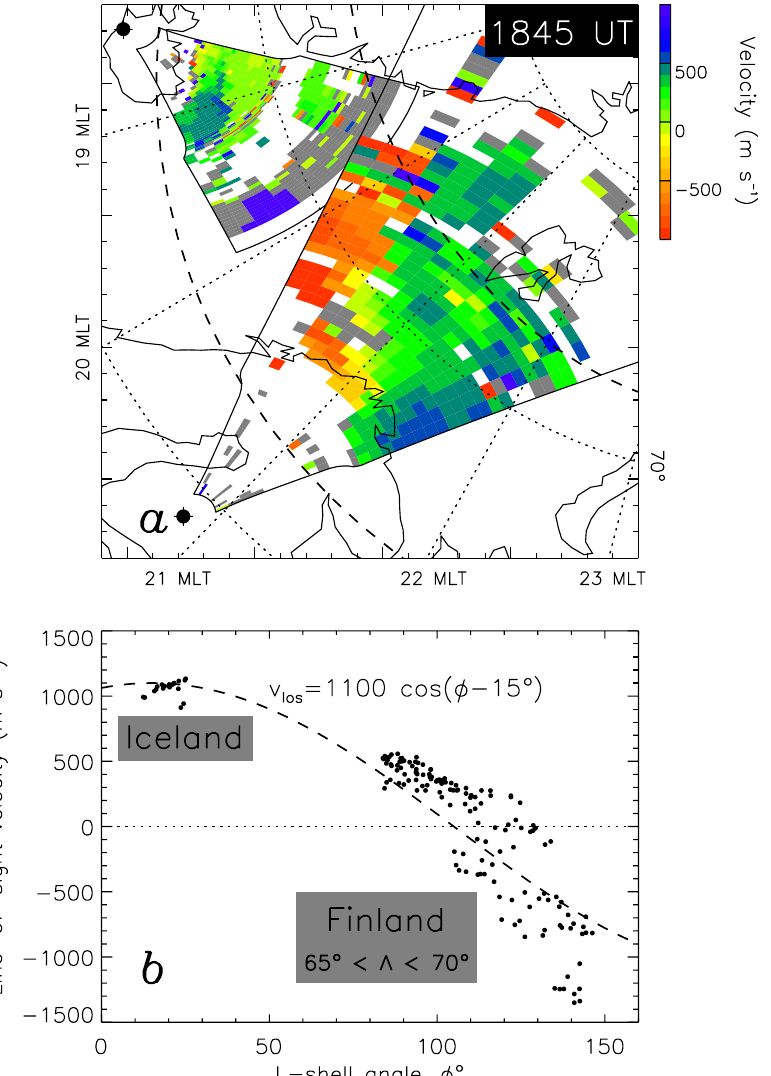
Fig. 14. (a) Magnetic latitude and MLT plot of Doppler shift observed in channel A of the Iceland East radar for the scan starting 18:44:57UT (top left), and simultaneous observations from the Finland radar (bottom left). Dashed lines show the extent of the statistical auroral oval. (b) Doppler shift as a function of L-shell angle for the Finland and Iceland East F-region observations below 70 ◦ magnetic latitude. Superimposed is a dashed curve indicating ν los = 1100cos (φ − 15 ◦ )